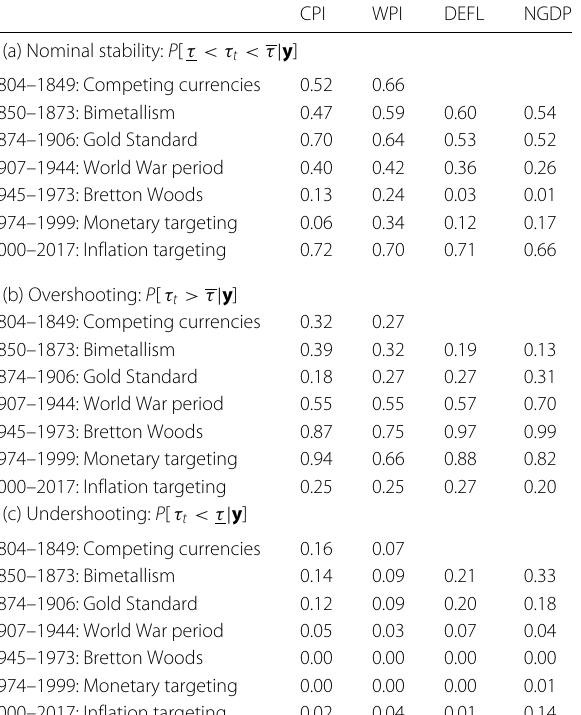
Table 6 Probability of nominal stability (with alternative definition of nominal